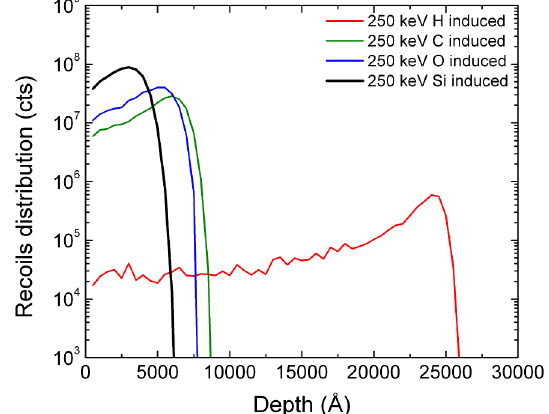
FIG. 12. The number of atomic recoils as a function of pene- tration depth for a variety of implanted ions.